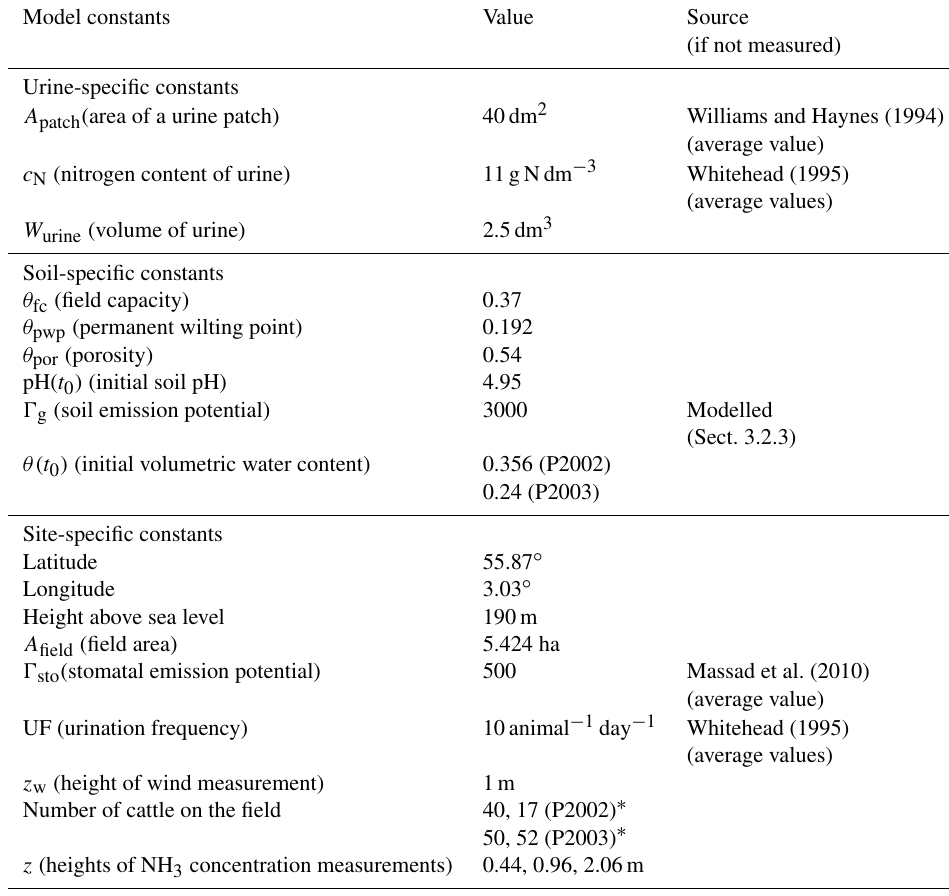
Table 2. Urine-, soil- and site-specific constants used in the evaluation of GAG_field. The source of the values that were not measured at the site are also indicated. P2002 and P2003 stand for the modelling periods in 2002 and 2003, respectively. Constants used in the model, but not mentioned here, were kept the same as defined for the baseline simulation with GAG_patch (Móring et al.,